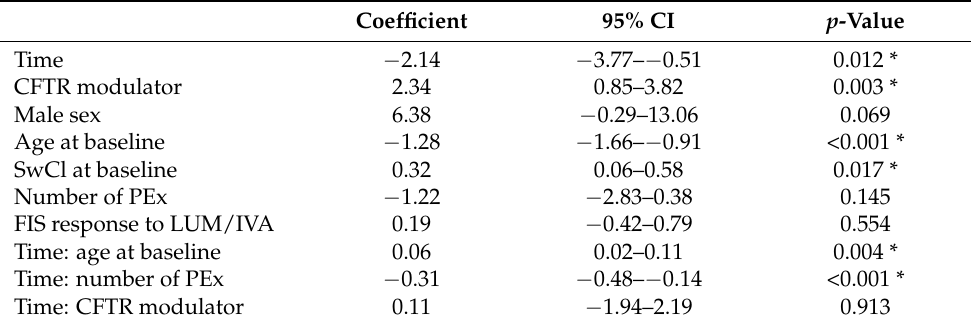
Table 2. Multivariable linear mixed effects model of ppFEV1 decline ( n = 94, obs =